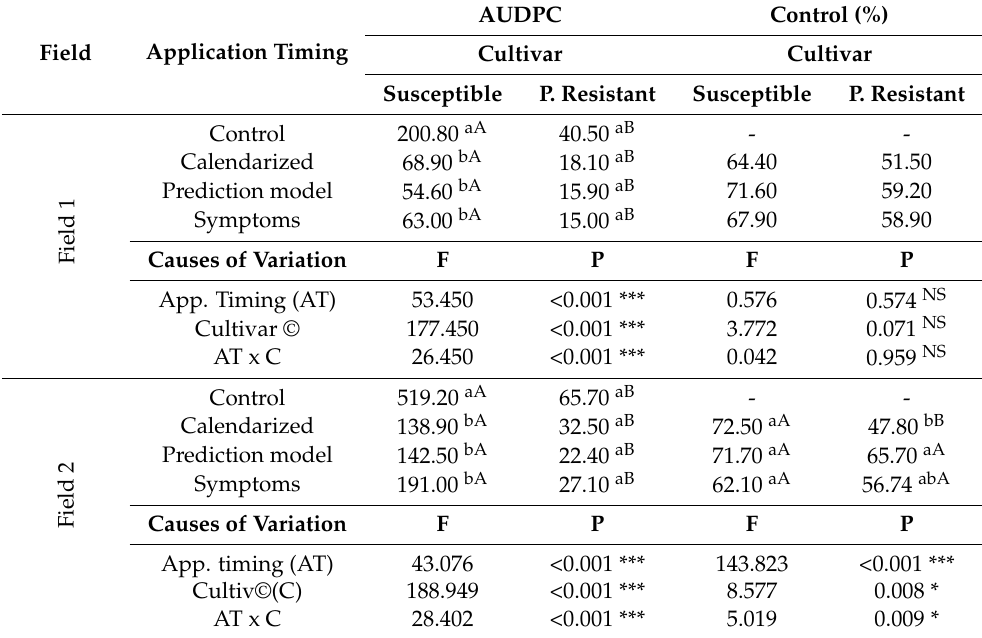
Table 4. Mean values of disease severity (AUDPC) and control (%) according to the application timings and susceptible and partially resistant soybean cultivars, for each field trial replication.